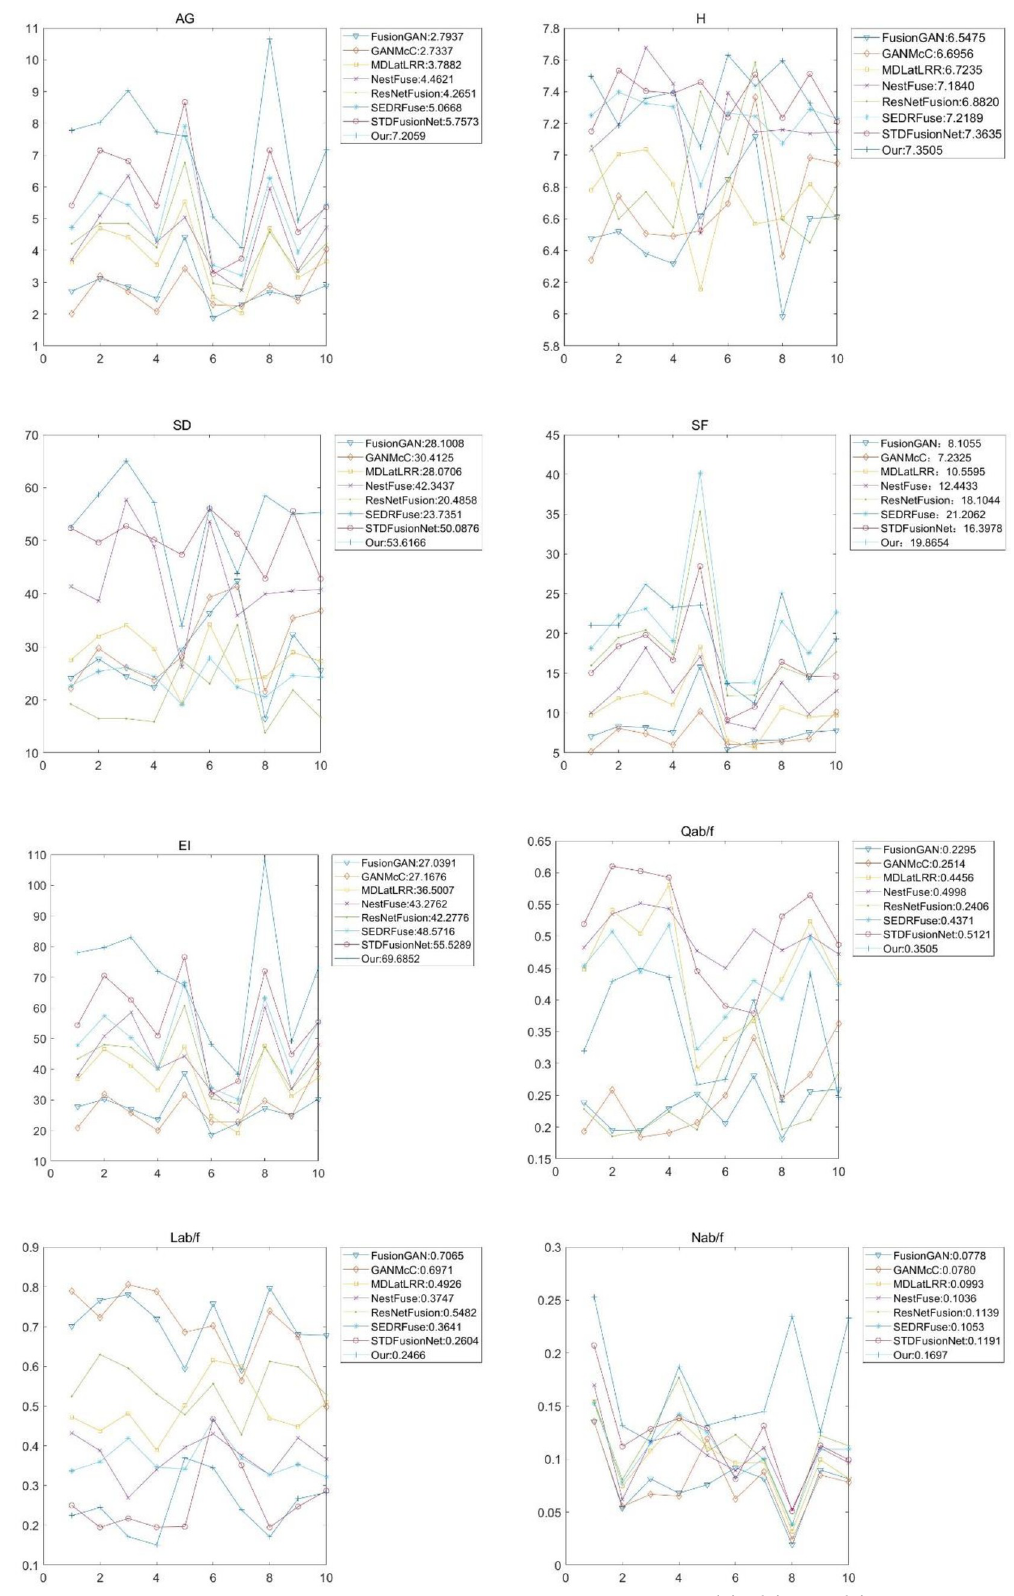
Fig 11. Quantitative comparisons in terms of the eight metrics: AG, H, SD, SF, EI, Q ab/f , L ab/f , and N ab/f , for ten image pairs from the TNO database. https://doi.org/10.1371/journal.pone.0278055.g011 PLOS ONE | https://doi.org/10.1371/journal.pone.0278055 December30,